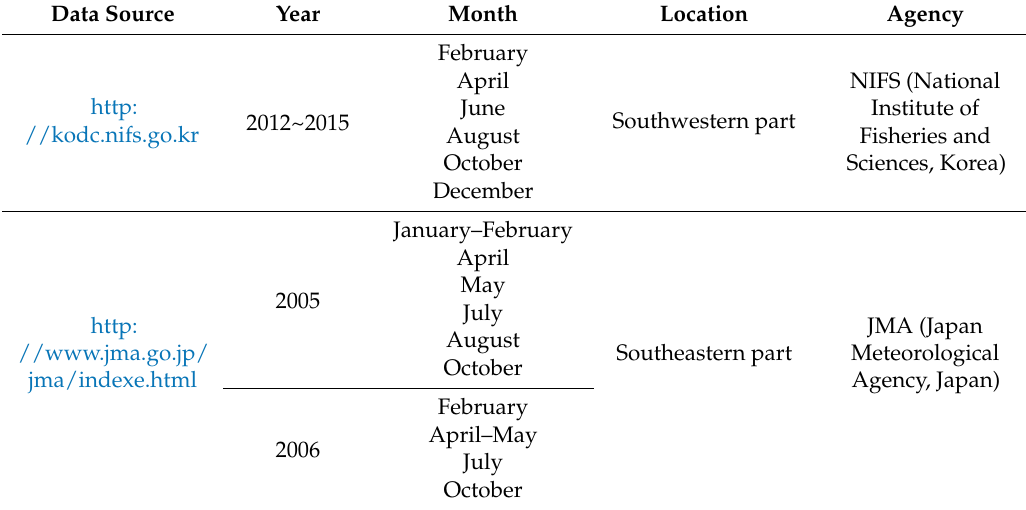
Table 1. Information for the field-measured nitrate concentrations in the East/Japan Sea